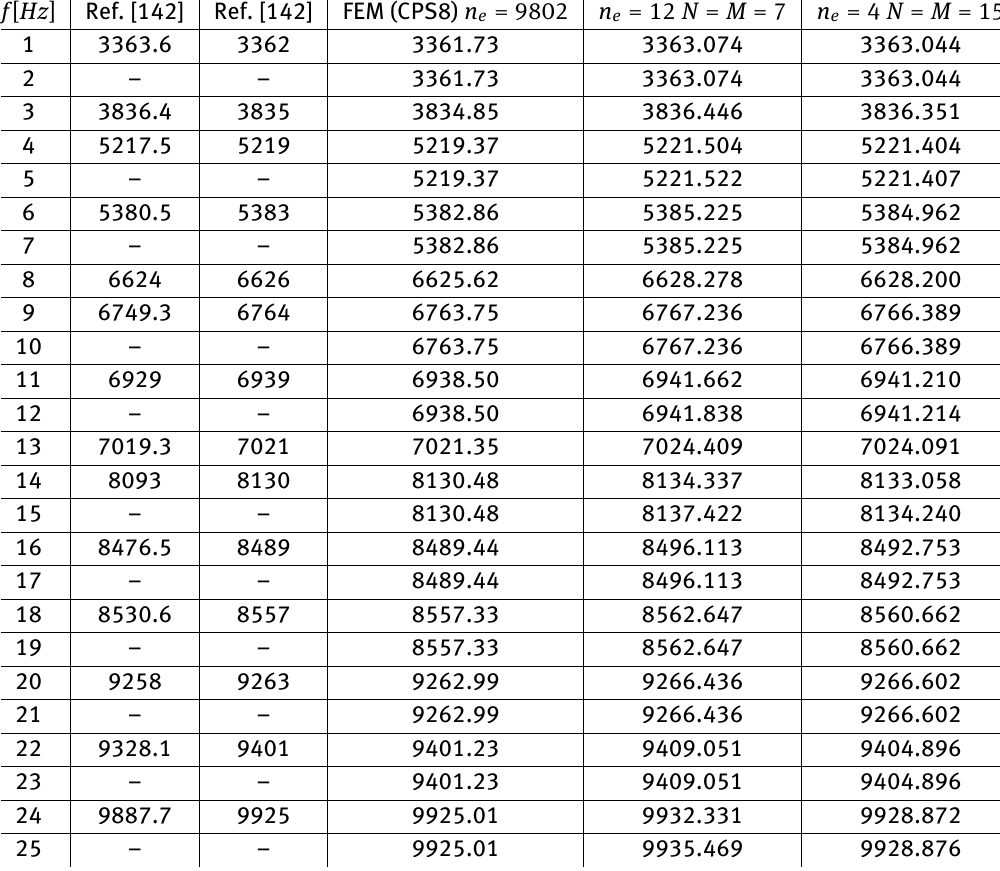
Table 3: First twenty-five frequencies for C-C-C-C isotropic circular plate using different